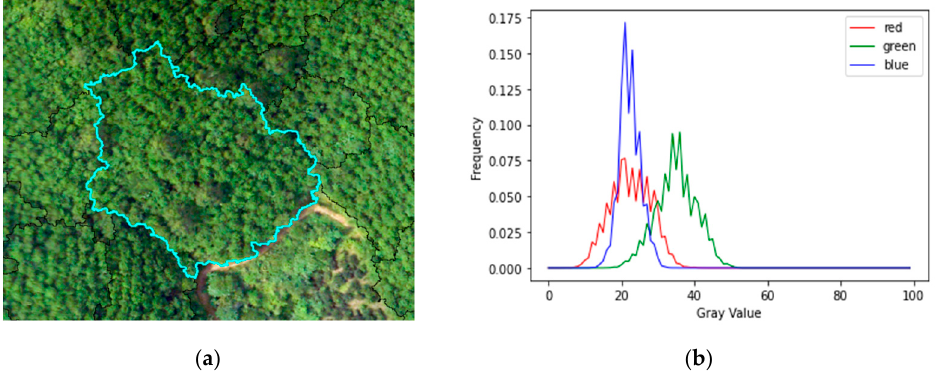
Figure 5. Grayscale histogram generated from aerial image of a forest stand. ( a ) A forest stand. ( b ) The histogram of the forest stand in bands R, G, and B.